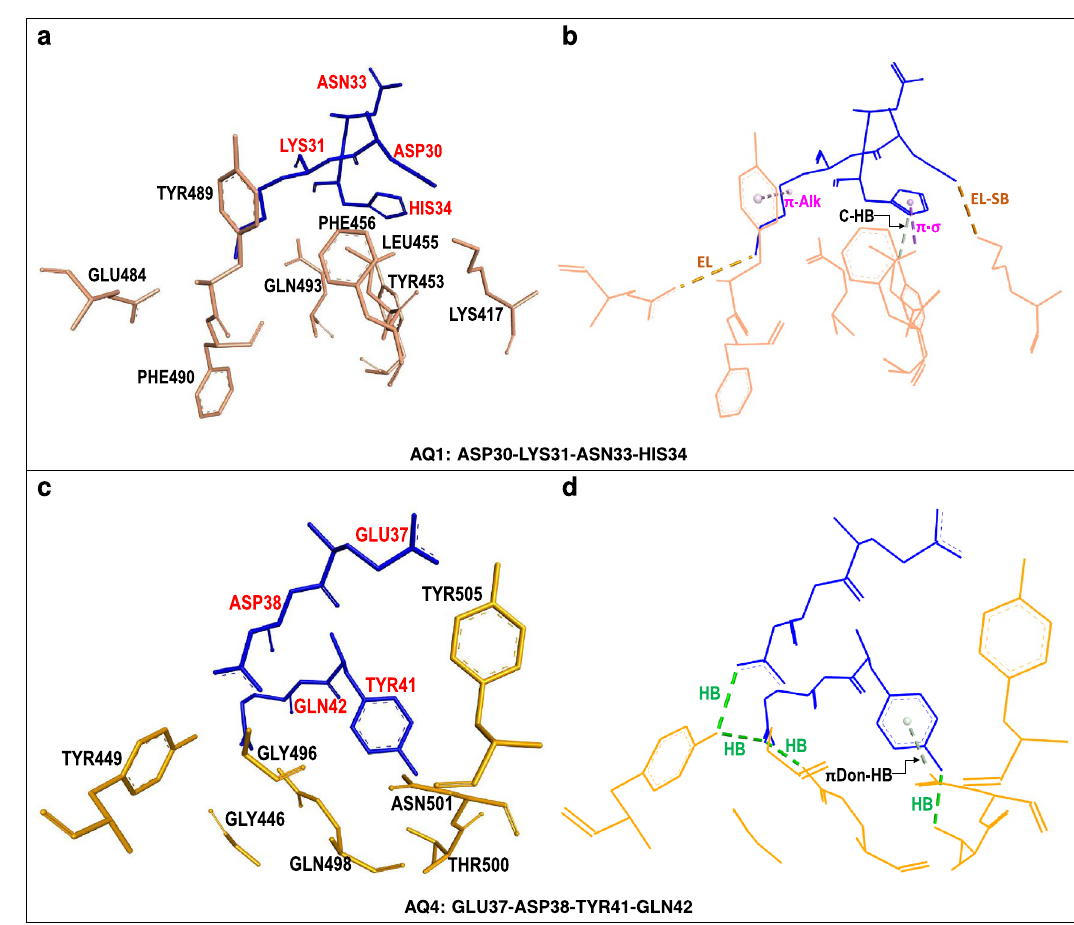
Figure 2. Two hACE2-centered supermolecular fragments giving rise to attractive hACE2...S-RDB interactions. ( a , c ) hACE2 quartet residues (shown in blue) and neighboring SARS-CoV-2 S-RBD residues (shown in gold) corresponding to the dominant attractive host-virus interaction energies. ( b , d ) Selected intermolecular interactions corresponding to (i) conventional hydrogen bonds (HB) (dotted green lines), (ii) carbon (non- classical) (C-HB) or π -donor hydrogen bonds ( π Don-HB) (dotted silver lines), (iii) π - σ or π -alkyl ( π -Alk) interactions (dotted pink lines) and (iv) electrostatic interactions (EL) including a salt bridge (EL-SB) (brown dotted lines). Quartet Human ACE2 receptor residues E DFT Int E DD Int E Total Int AQ1 ASP30-LYS31-ASN33-HIS34 − 58.31 − 26.36 − 84.67 + 41.22 − 15.90 + 25.32 GLU329-ASN330-LYS353-GLY354 + 26.79